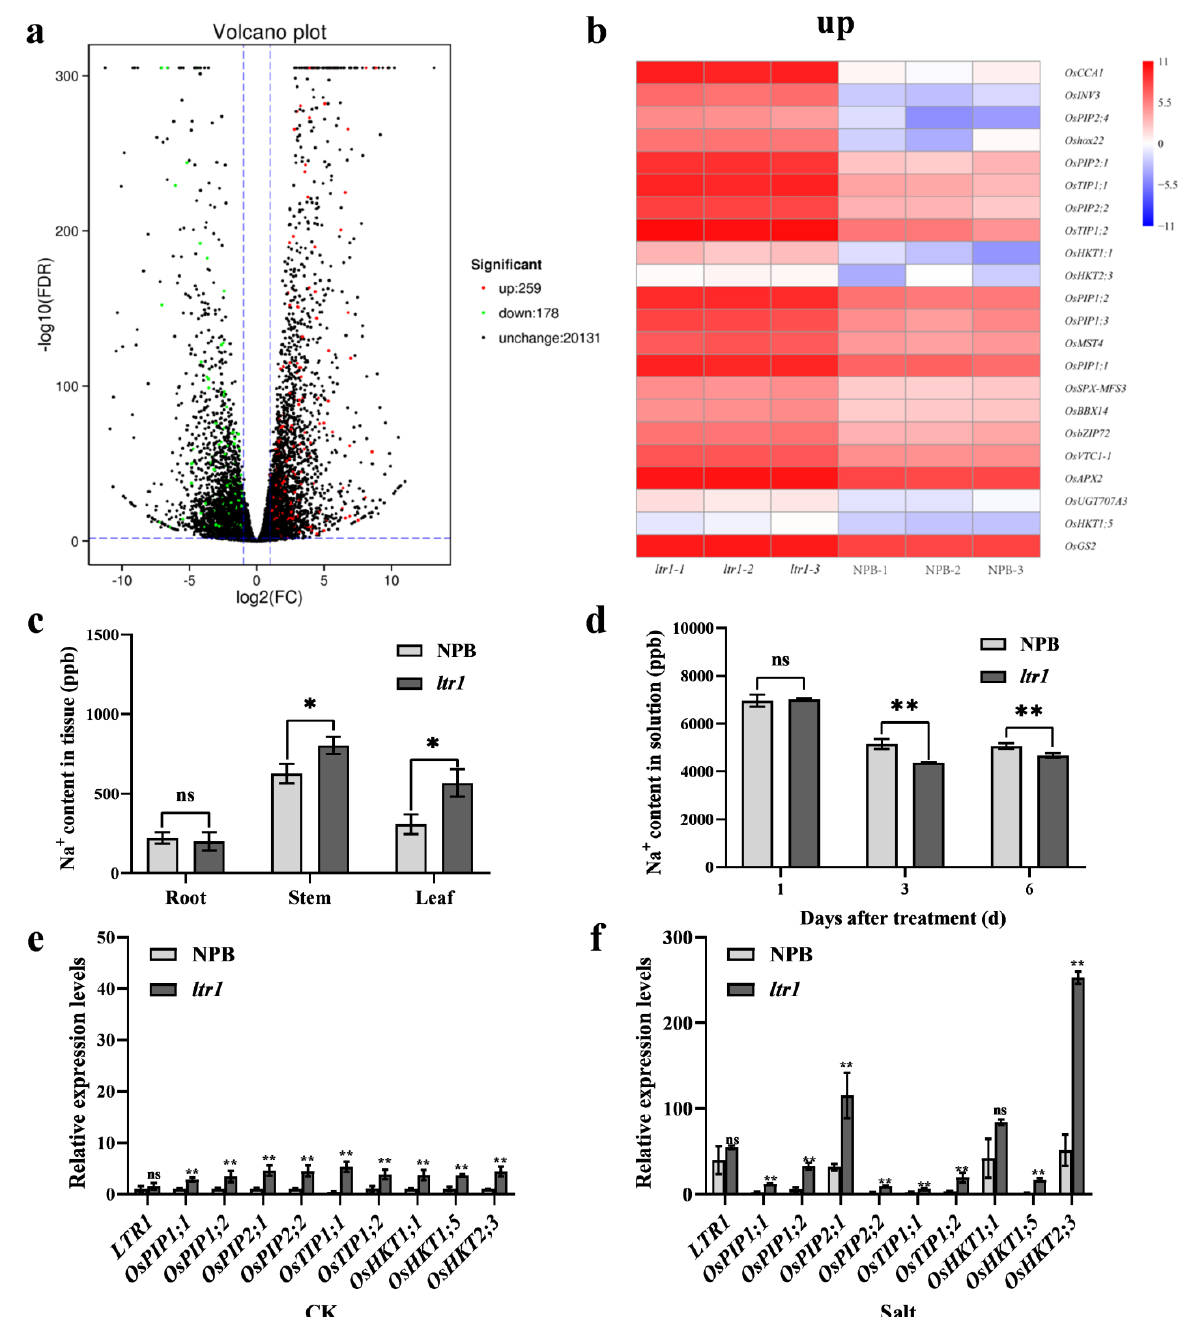
Figure 7. LTR1 regulates salt-stress response by regulating genes encoding aquaporins and ion transporters. ( a ) Volcano plot of DEGs related to salt response between NPB and ltr1 . ( b ) Heat map of significantly up-regulated DEGs encoding aquaporin and ion transporters between NPB and ltr1 . ( c ) Na + content in different tissues of NPB and ltr1 . ( d ) Na + content in solutions where NPB and ltr1 were cultured after treatment for 1, 3, or 6 d. ( e ) Relative expression levels of LTR1 and genes encoding aquaporin and ion transporters under normal condition (CK). ( f ) The relative expression levels of LTR1 and genes encoding aquaporin and ion transporters under 150 mM NaCl (Salt). Data are given as means ± SD. Asterisks indicate significant difference based on the Student’s t -test: * in the figure represents significant difference at p < 0.05; ** in the figure represents significant difference at p < 0.01 and ns in the figure represents there is no significant difference at p <